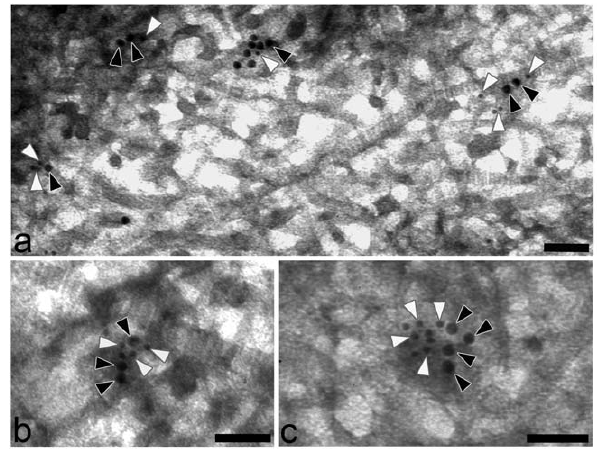
Figure 3. Representative ultrathin sections of articular carti- lage of adult mice co-stained for WARP (18-nm gold particles; black arrow heads) and collagen VI (12-nm gold particles; white arrowheads). Scale bars: 100 nm.